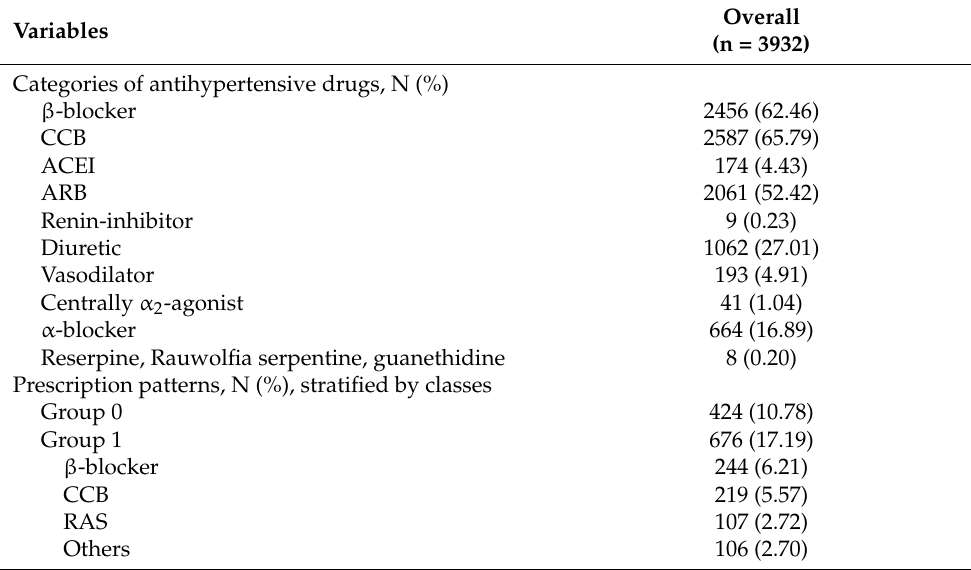
Table 2. Prescription Pattern of Non-operated AD